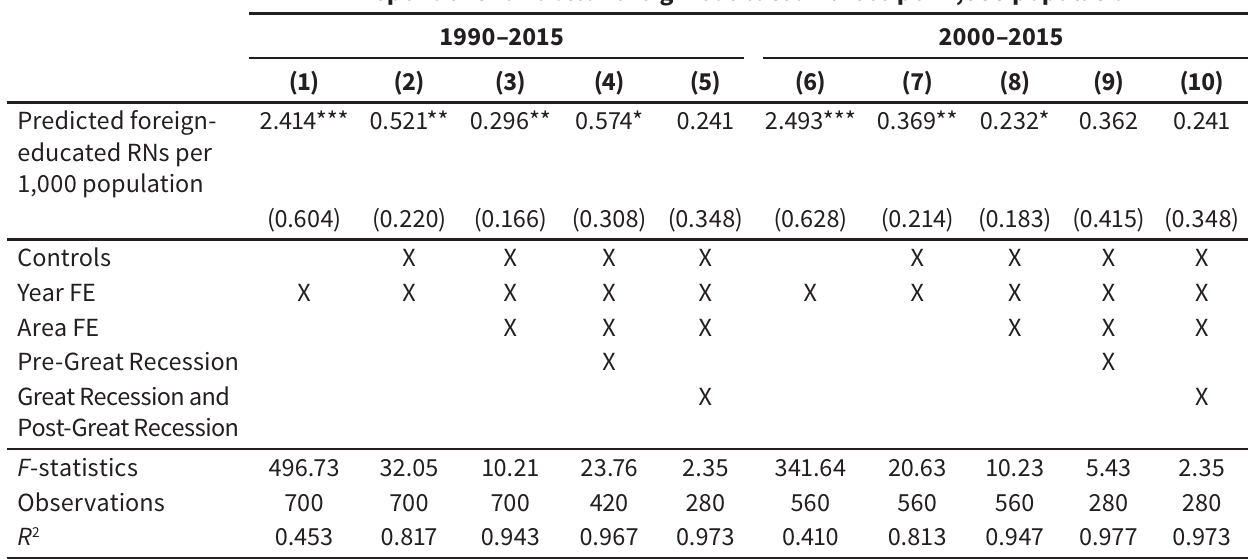
The first-stage regressions Dependent variable: Foreign-educated nurses per 1,000